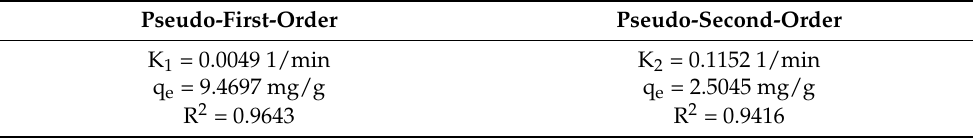
Table 2. Kinetics